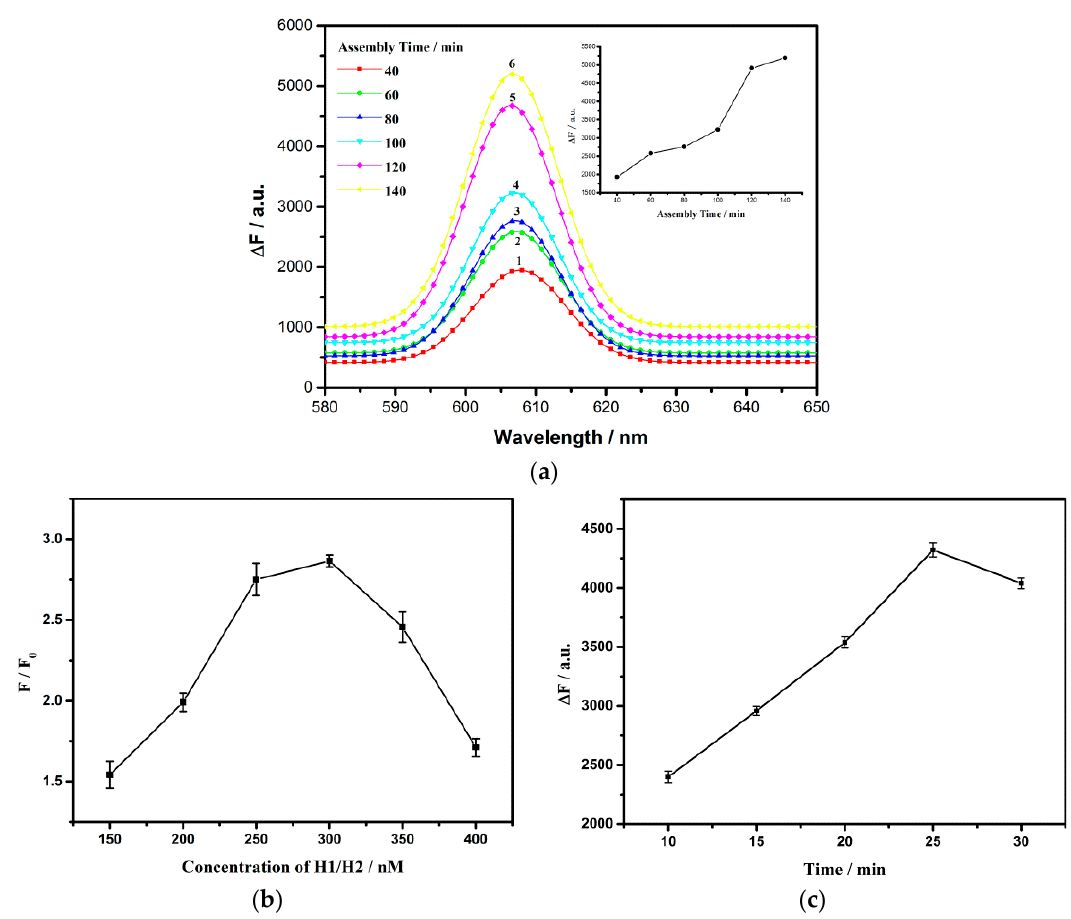
Figure 7. ( a ) The change in fluorescence emission spectra to different assembly time. Inset: the change in fluorescence emission intensity at 608 nm from NMM vs the assembly time; ( b ) The change in fluorescence emission spectra to the reaction time between G-quadruplex structure and NMM; ( c ) The change in fluorescence emission spectra to the concentration of H1 and H2. Error bars show the standard deviation of three experiments.